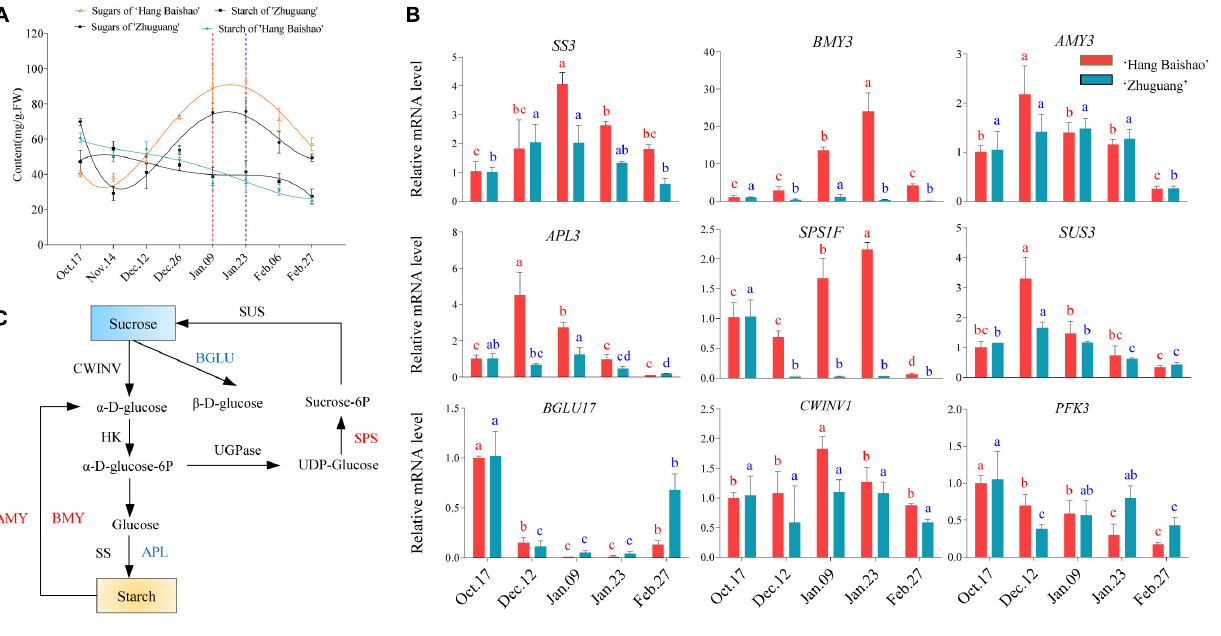
FIGURE 2 | Starch and sucrose metabolism and the expression of related key genes during bud dormancy. (A) Concentrations of soluble sugar and starch in the two cultivars. The data were fitted with a third-order polynomial by GraphPad Prism 9.0. The dashed red line indicates the bud endodormancy release date of low CR ‘Hang Baishao,’ and the dashed blue line indicates the bud endodormancy release date of high-CR ‘Zhuguang.’ (B) Relative mRNA levels related to sucrose and starch metabolism analyzed by qRT–PCR. (C) Summary of different factors in the starch and sucrose metabolism pathways during bud dormancy. Red indicates upregulation, and blue indicates downregulation. Error bars represent standard deviation from three biological replicates and different letters indicate significant differences ( P < 0.05). Differences were compared among different move dates for each cultivar.